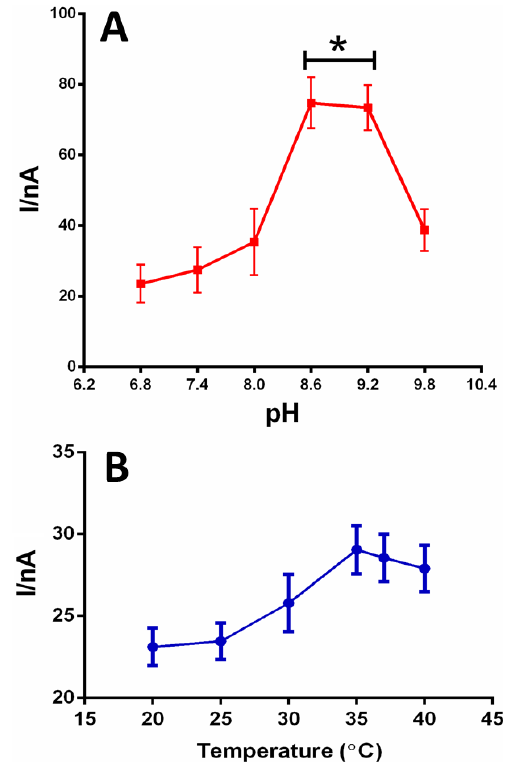
Figure 5. The influence of pH ( A ) and temperature ( B ) on the response of the biosensor Pt /PPD/[{PEI(1%)+Glyc (1%)}/AOx]10/PU(1%), with 200 U·mL −1 of enzyme c